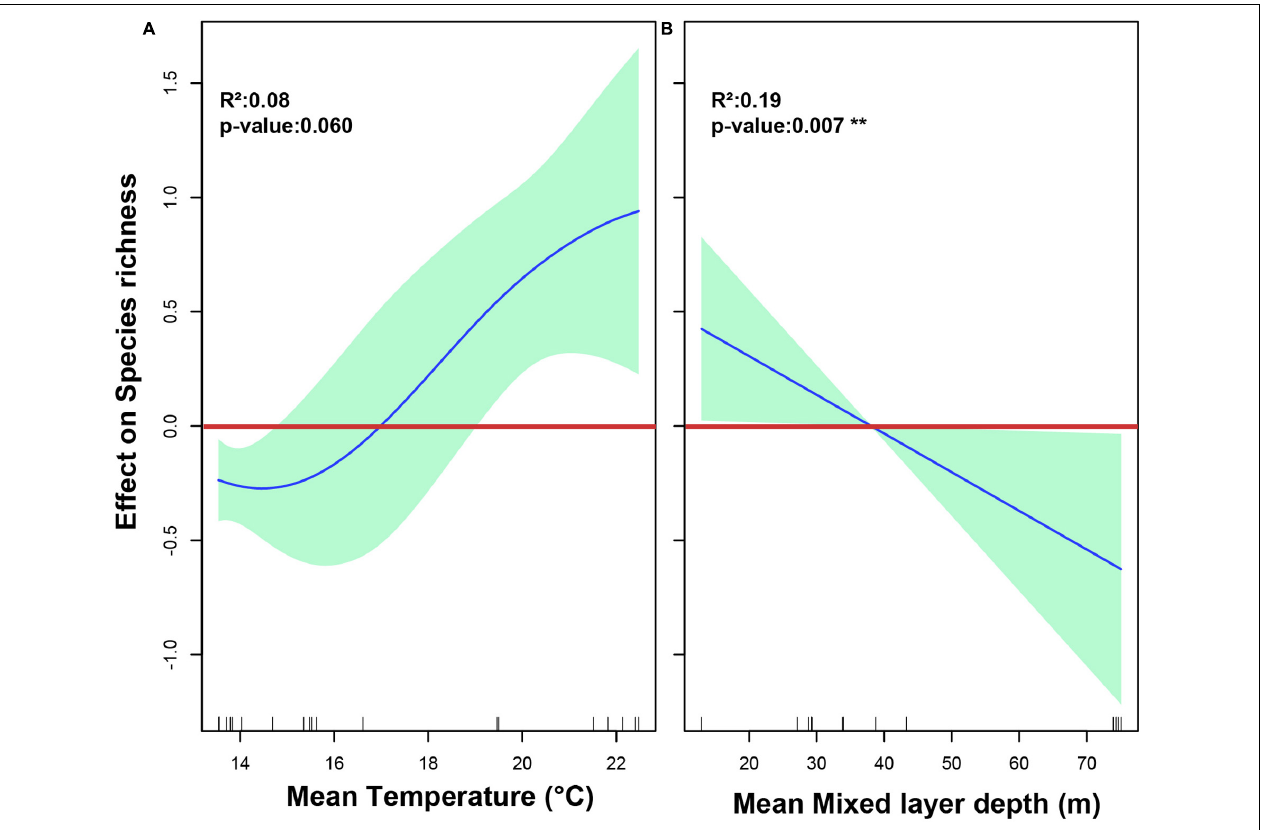
FIGURE 10 | The relationship between oceanographic variables and species richness of calanoid copepods found in the 0–200 m layer in the southeast Pacific, as represented by a generalized additive model (GAM). (A) The effect of Mean sea surface temperature on species richness. (B) The effect of mean depth of the mixed layer on species richness. Spline fit (solid blue line) is bound at 95% confidence intervals (light green area). Values > 0 indicate a positive effect on richness, values < 0 indicate a negative effect. The rug plot (dashes above the x -axis) represents the distribution of data